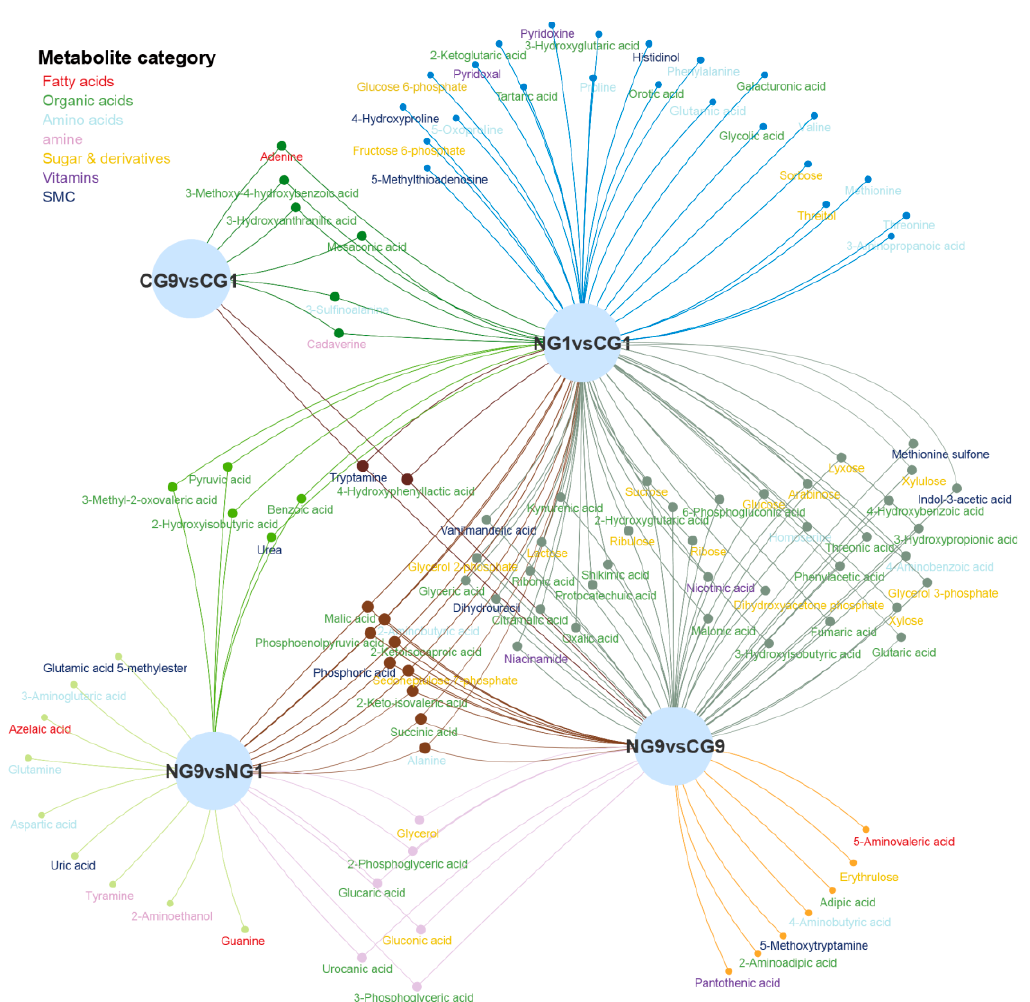
Figure 4. Venn network of metabolites, which differed significantly between genotypes and between treatments.